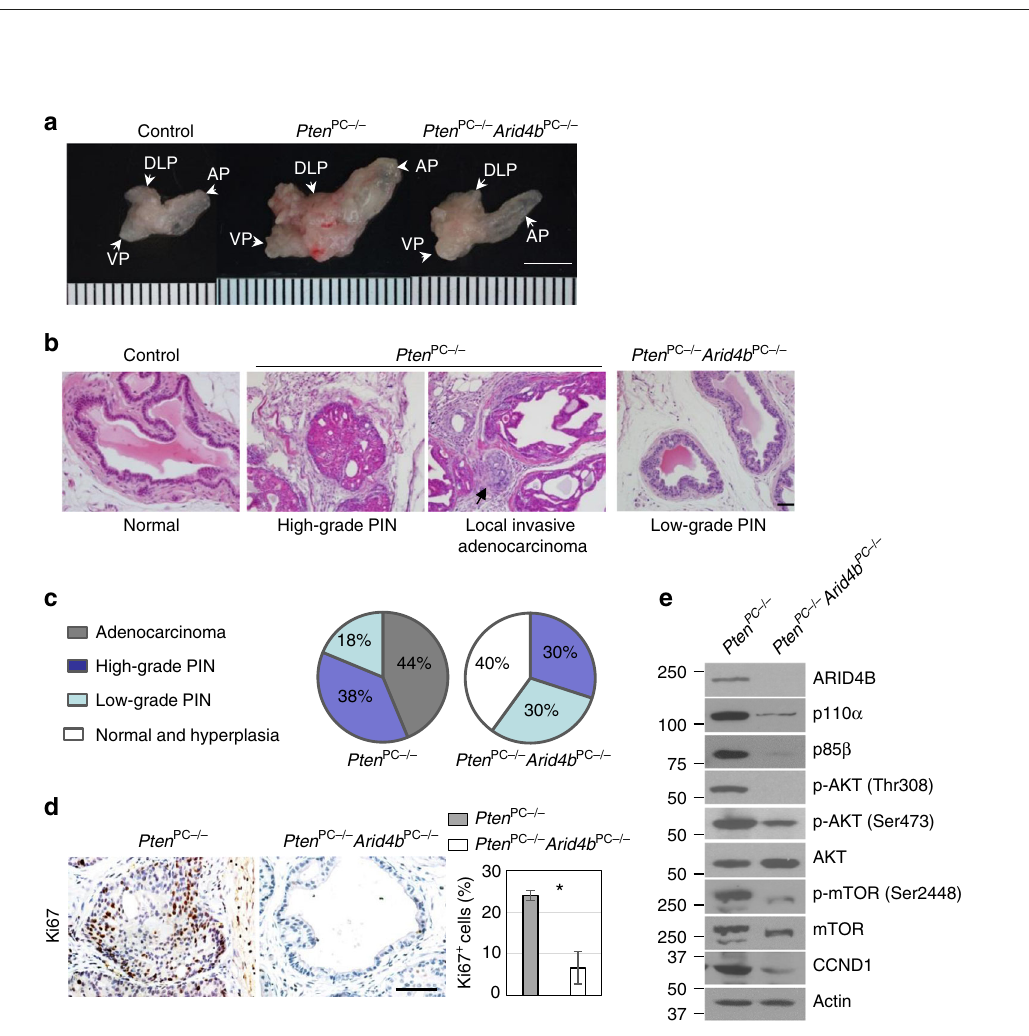
Fig. 3 ARID4B is required for tumor growth of PTEN-de fi cient prostate cancer. a Genomic alterations of ARID4B and PTEN in prostate adenocarcinoma from fi ve prostate cancer genomic datasets. b Proliferation of control and ARID4B KO PC3 cells was measured by MTT assays. c Comparisons of cell migration, cell invasion, and tumorsphere formation between control and ARID4B KO PC3 cells. d Representative images of excised tumors (left) and measurement of tumor growth (right) from xenografts in mice injected with control or ARID4B KO PC3 cells. Data are means± SEM (right). e Representative images (left) and quanti fi cation (right) of immunohistochemical staining with Ki67 (cellular marker of proliferation) on excised tumors from mice injected with control or ARID4B KO PC3 cells ( n = 3 for each group). Scale bar, 50 mm. Data are means ± SEM from three experiments performed in triplicate ( b , c , e ). ** P < 0.01 ( b , d , e ); *** P < 0.001 ( c ); Statistical analysis: t